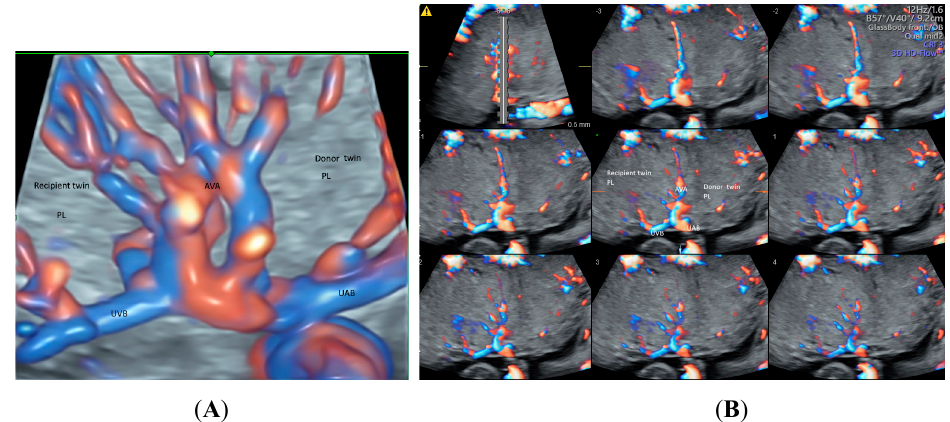
Figure 9. Demonstration of deep arteriovenous anastomosis in a complicated monochorionic twin pregnancy at 25 weeks’ gestation by spatiotemporal image correlation volume acquisition in high- definition Doppler displayed in glass-body mode ( A ) and tomographic ultrasound imaging ( B ). Note umbilical artery (UAB) and vein branches (UVB) from two twins converged into the same placental lobule (PL), and the deep arteriovenous anastomoses (AVA).